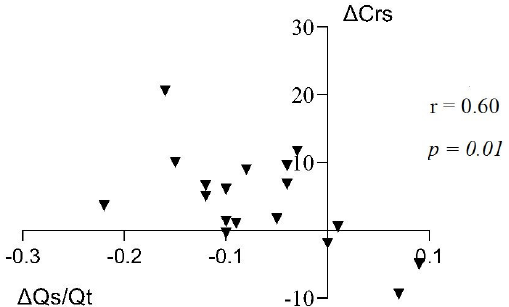
Figure 2. Pearson’s correlation coefficient (r) and p -value ( p ) between the change in shunt fraction ( Δ Q ̇ s/Q ̇ t) and the synchronous change in the compliance of the respiratory system ( Δ Crs, ml/mbar).